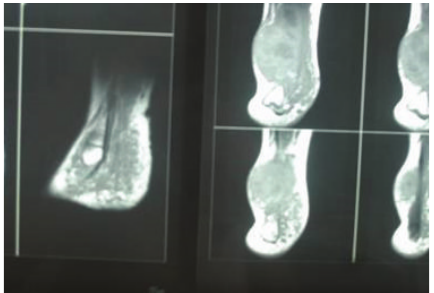
Figure 4: MR images showed the presence of a huge mass of the right calf and